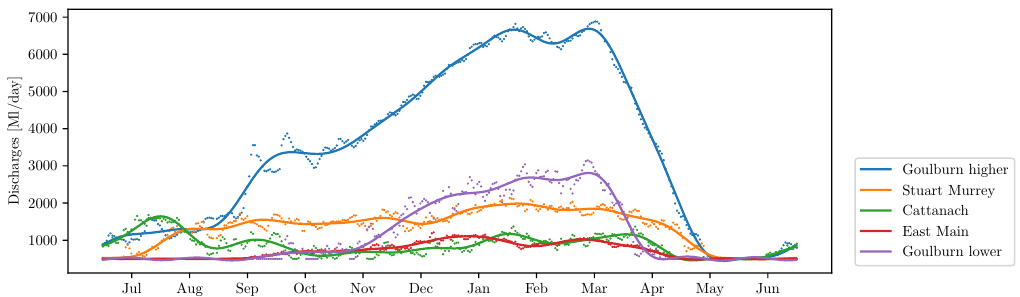
Figure 2. Average daily discharges ( dotted lines ) and the approximating smooth periodic functions ( solid lines